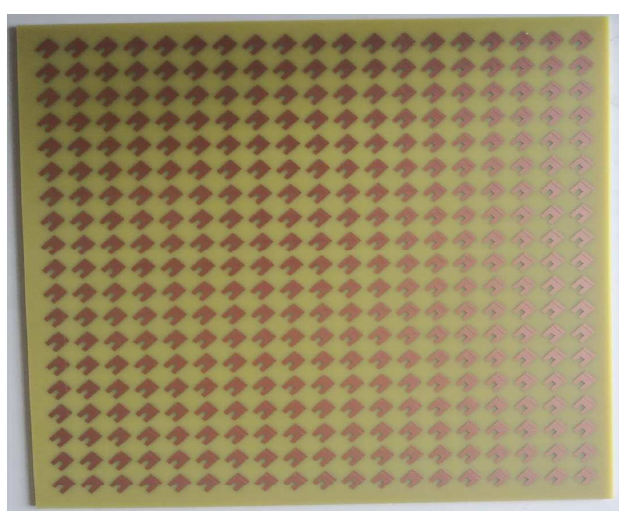
Figure 9. The fabricated 300 mm × 300 mm prototype.